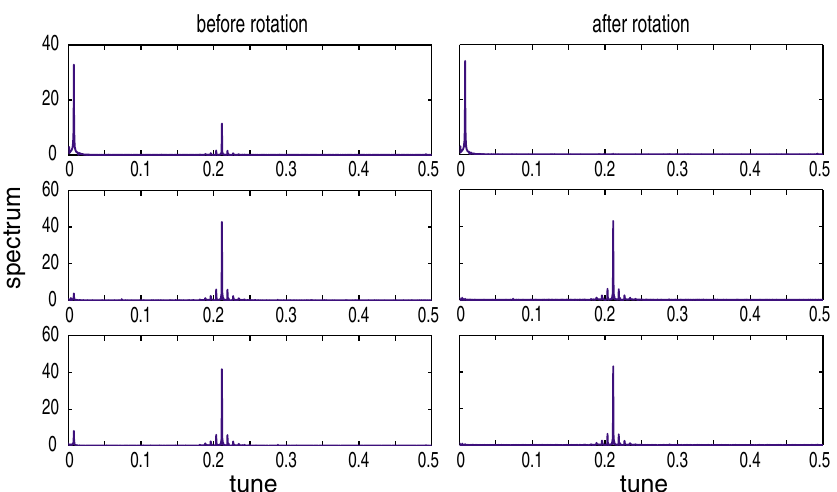
FIG. 6. (Color) Similar to Fig. 5 but using 50 instead 186 BPMs. Now the mode mixing is significant in the SVD modes but is apparently removed by a rotation.